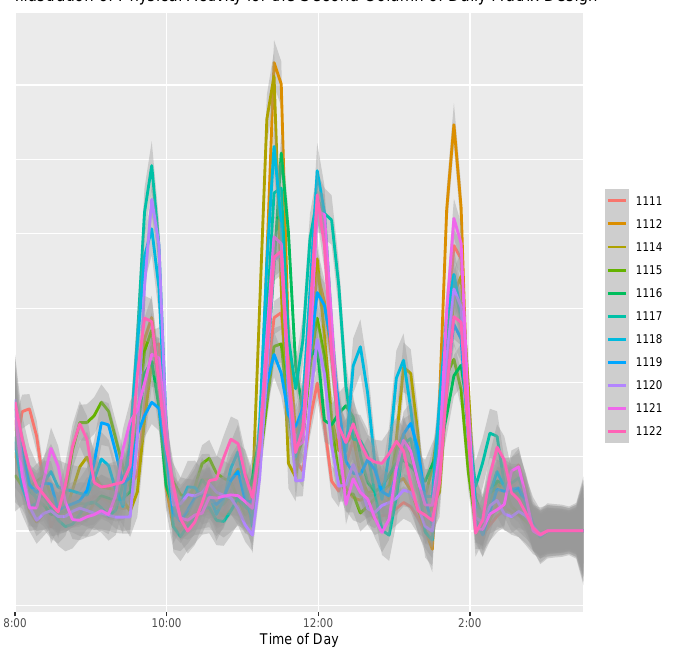
Figure 8. Second column of daily activity for 11 subjects across four weeks. The proposed model with two-time scales along with a = 3, b = 1, c = 3, and d = 1 as ridge penalties was applied to real data